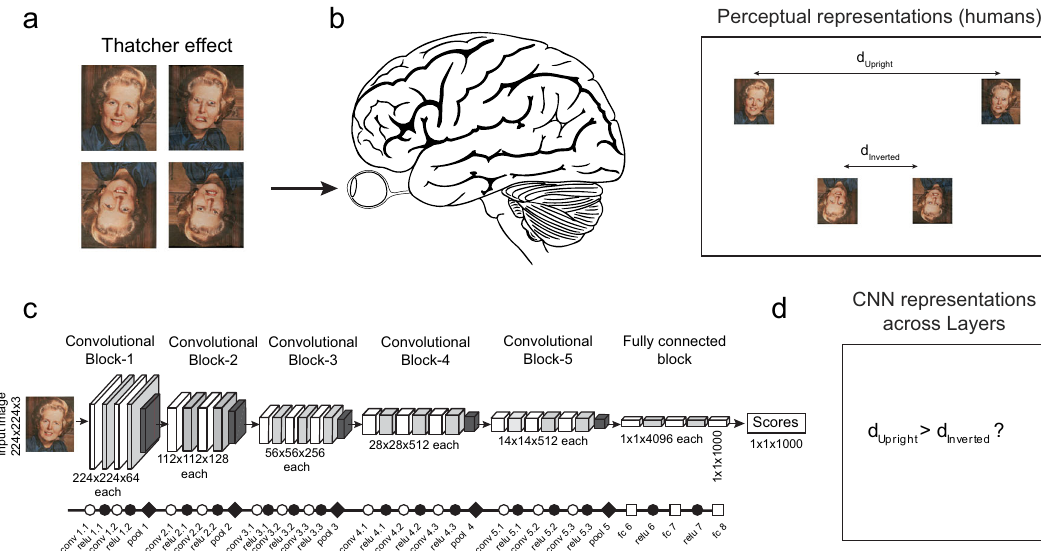
Fig. 1 Evaluating whether deep networks see the way we do. a In the classic Thatcher effect, when the parts of a face are individually inverted, the face appears grotesque when upright ( top row ) but not when inverted ( bottom row ). Figure credit: Reproduced with permission from Peter Thompson. b When the brain views these images, it presumably extracts speci fi c features from each face so as to give rise to this effect. We can use this idea to recast the Thatcher effect as a statement about the underlying perceptual space. The distance between the normal and Thatcherized face is larger when they are upright compared to when the faces are inverted. This property can easily be checked for any computational model. Brain Image credit: Wikimedia Commons . c Architecture of a common deep neural network (VGG-16). Symbols used here and in all subsequent fi gures indicate the underlying mathematical operations perfomed in that layer: un fi lled circle for convolution, fi lled circle for ReLu, diamond for maxpooling and un fi lled square for fully connected layers. Un fi lled symbols depict linear operations and fi lled symbols depict non-linear operations. d By comparing the distance between upright and inverted Thatcherized faces, we can ask whether any given layer of the deep network sees a Thatcher